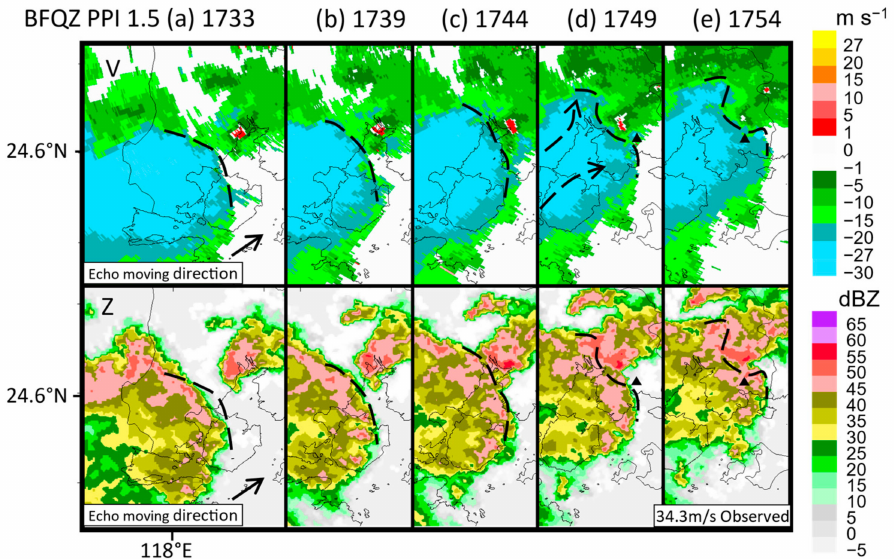
Figure 9. Doppler velocities (upper panels) (shaded; unit: m s − 1 ) and reflectivity (bottom panels) (shaded; unit: dBZ) at 0.5 ◦ PPI observed by BEQZ at 17:33 LST ( a ), 17:39 LST ( b ), 17:44 LST ( c ), 17:49 LST ( d ), and 17:54 LST ( e ). The dashed line indicates a front of radial velocity greater than 20 m s − 1 relating to the bow echo. The dashed arrows show the inflows. The black triangles indicate the locations of wind